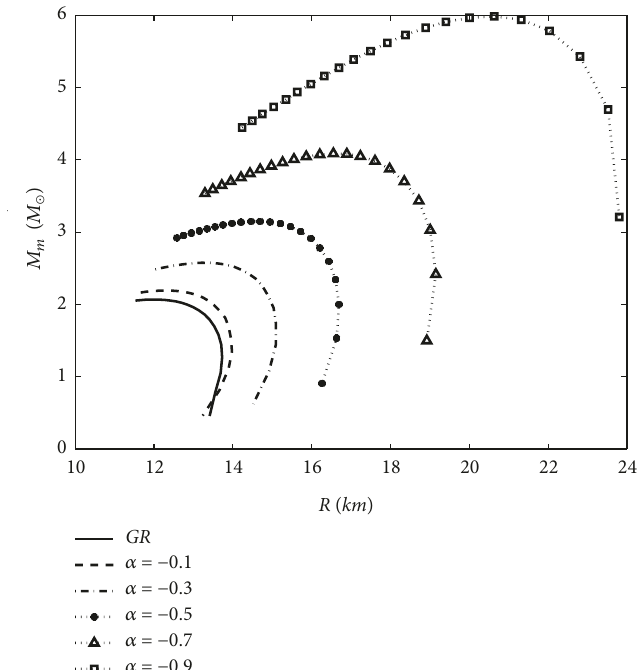
Figure 7: The figure shows the dependence of the mass of the star as a function of its radius (figure taken from [18]).